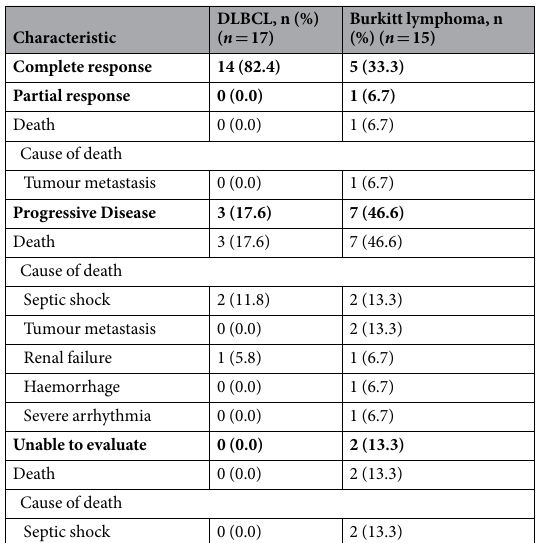
Table 2. Outcome and causes of death following chemotherapy in HIV-infected patients with lymphoma. HIV, human immunodeficiency virus; DLBCL: diffuse large B-cell